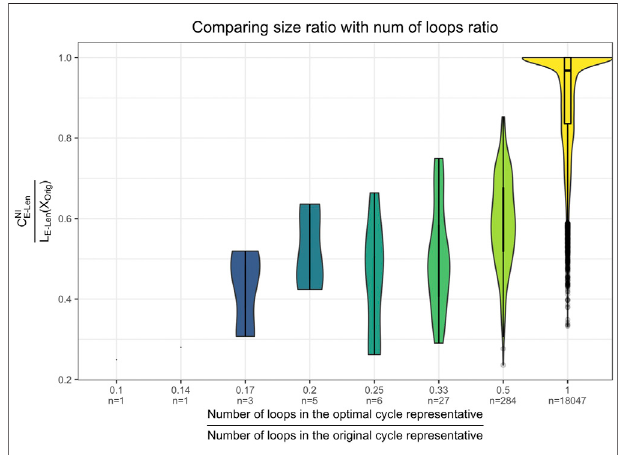
FIGURE 11 | Violin plot of the effectiveness of the optimization as a functionofthenumber ofloopsintheoriginalcyclerepresentative. Results are aggregated over the data sets from Section 5.1 and Section 5.2 . The x -axis shows the size reduction in terms of number of loops, and the y -axis shows the size reduction in terms of the length of the cycle. We see that in general, the reduction in size of the original cycle mostly comes from the reduction in the number of loops by the